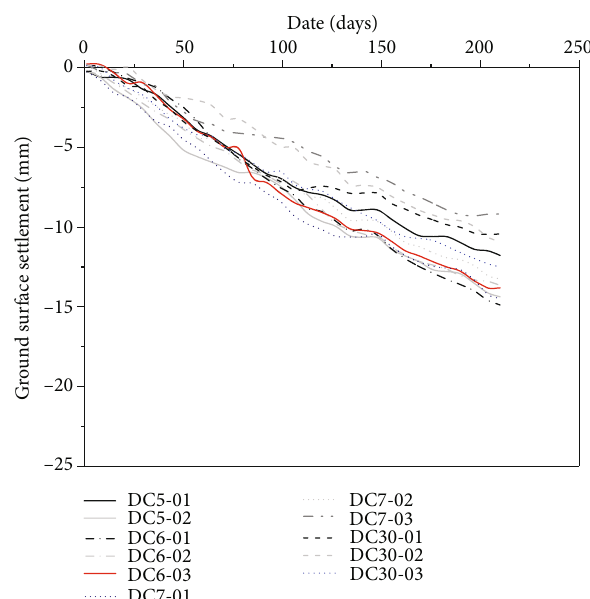
Figure 6: Time histories of ground surface settlements along lines of DC13, DC23, and